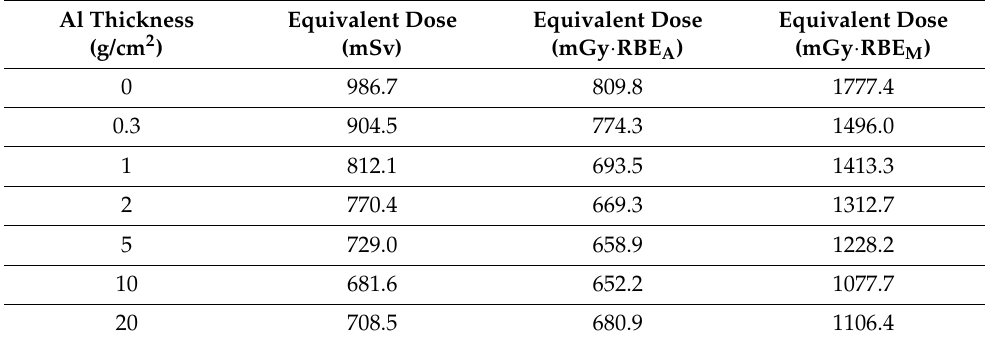
Figure 5. Calculated values of Q, dicentric RBE M and dicentric RBE A with different Al shielding thicknesses at solar minimum. Table 6. Equivalent doses for 650 days in free space at solar minimum, calculated by multiplying the absorbed doses (in mGy) either by Q (column 2), by the dicentric RBE A , (column 3) or by the dicentric RBE M (column